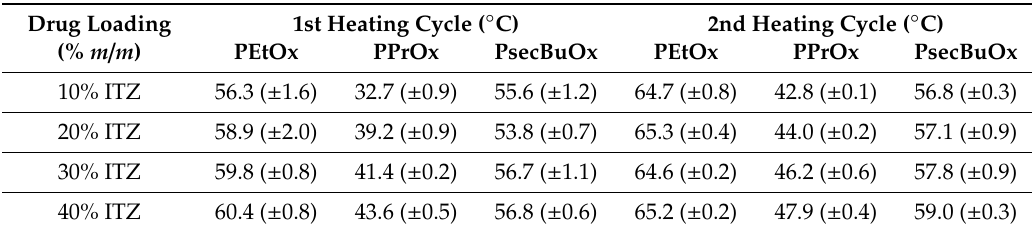
Table 4. Average T g s ( ± standard deviation) of binary ASDs with ITZ and PEtOx, PPrOx or PsecBuOx. mDSC measurements were performed in triplicate. Drug loading was increased from 10% to 40% IND. Drug Loading 1st Heating Cycle ( ◦ C) 2nd Heating Cycle ( ◦ C) PEtOx